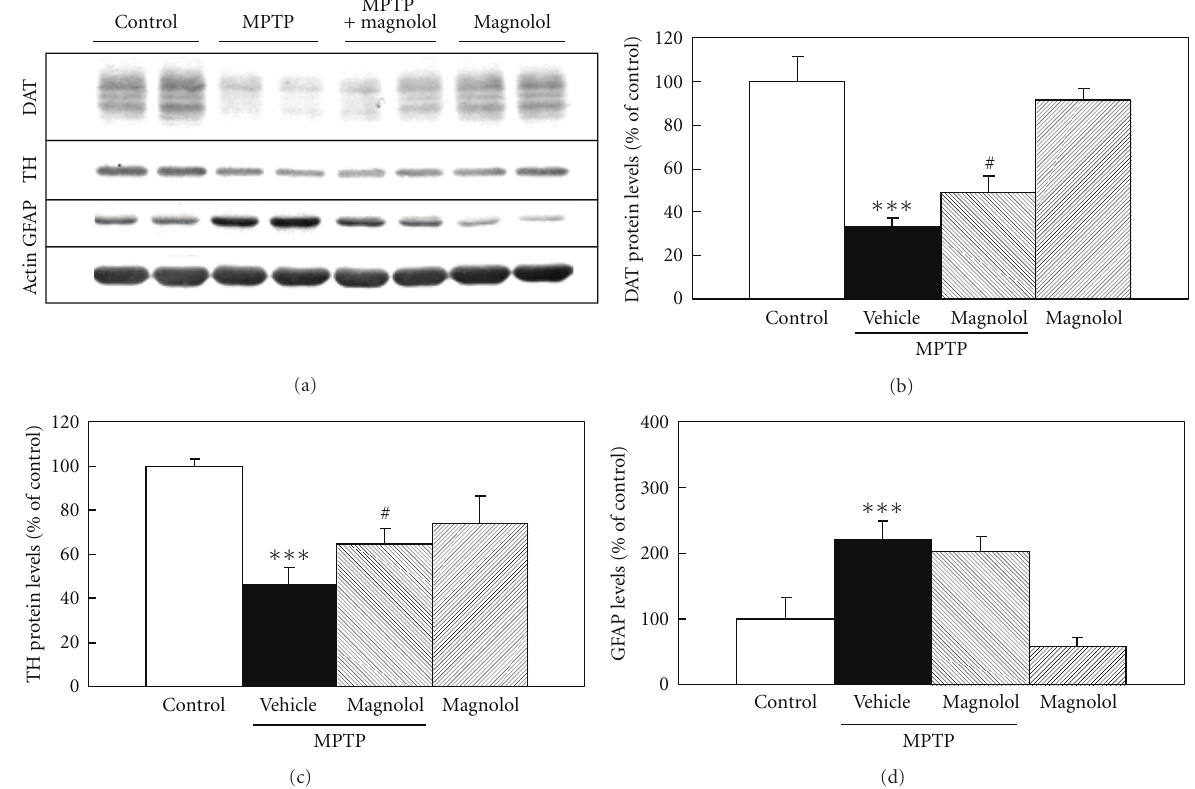
Figure 3: E ff ect of post-MPTP treatment with magnolol on DAT, TH, and GFAP protein levels in the striatum of C57BL/6 mice. Mice were received a single injection of 40 mg/kg MPTP and administered daily with magnolol (30mg/kg) for 4 days at the day just after MPTP treatment. The evaluations were performed at 1 h after the last treatment with magnolol. Representative immunoblots of DAT, TH, and GFAP protein in the striatum are shown (a). Actin protein was used as house keeping protein. Immunoblots of DAT (b), TH (c), and GFAP (d) in the striatum were quantified in each group. Densitometric analysis of protein bands was performed using software (Image J 1.36, NIH). The data were expressed as % of control. Results are means ± SD ( n = 3-4) from three independent experiments. Statistical comparisons were carried out by one-way ANOVA followed by Tukey test. ∗∗∗ P < 0 . 001 versus control, # P < 0 . 05 versus MPTP +